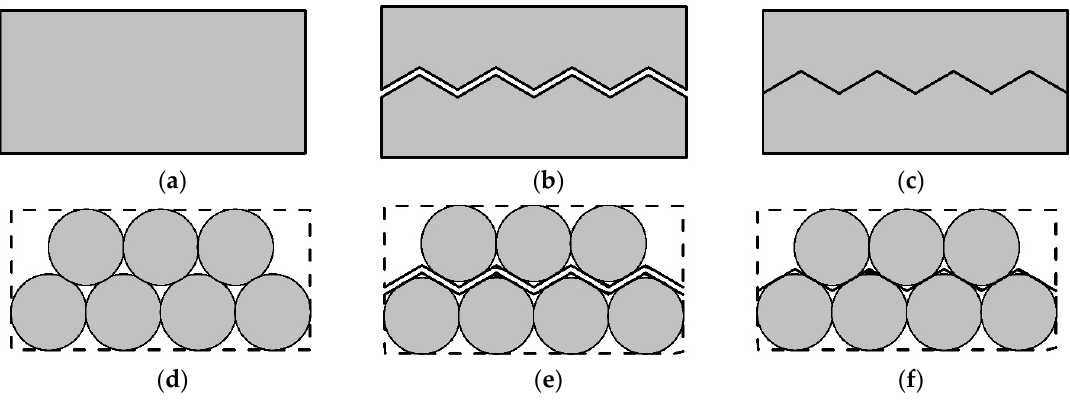
Figure 1. the shape ( a ); the crack ( b ); the contact ( c ) of a cemented solid material, and the shape ( d ); the crack ( e ); the contact ( f ) of a cemented granular